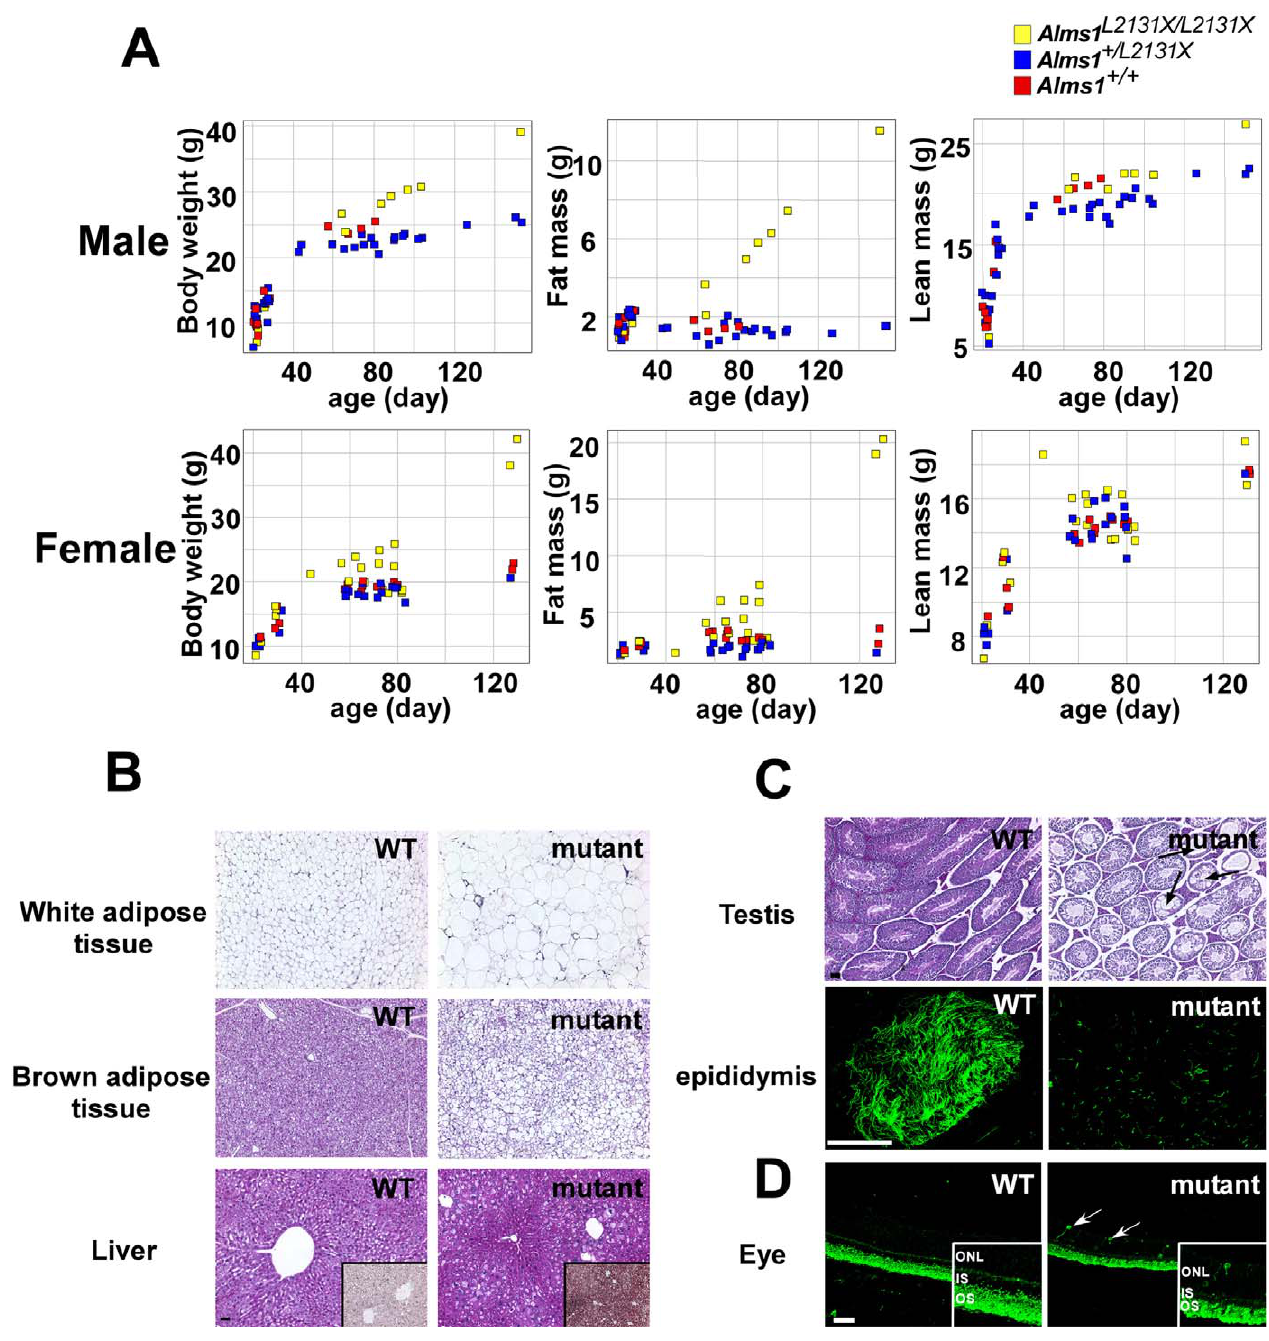
Figure 4. Alms1 L2131X/L2131X Mice Recapitulate Human Alstro¨m